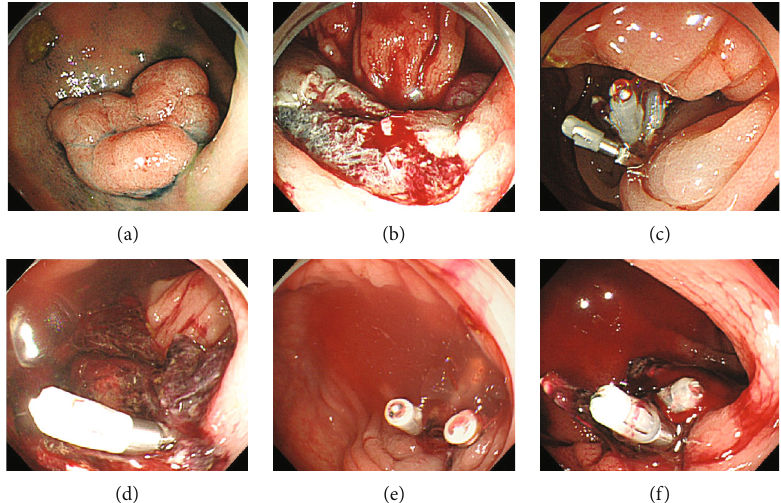
Figure 4: A case treated with DOACs in which postoperative hemorrhage occurred twice after EMR. (a) A 76-year-old man receiving apixaban with no antiplatelets and hemodialysis. A nonpolypoid lesion 25mm in size on the transverse colon. (b) EMR was performed. (c) Endoscopic clipping was performed in the EMR ulcer. (d) Postoperative hemorrhage occurred two days after EMR. One previous endoscopic clipping remained in the EMR ulcer. (e) Endoscopic clipping was performed again for hemostasis. (f) Postoperative hemorrhage occurred a second time three days after EMR. Endoscopic clipping was performed again, and no recurrent postoperative hemorrhage occurred after this round of